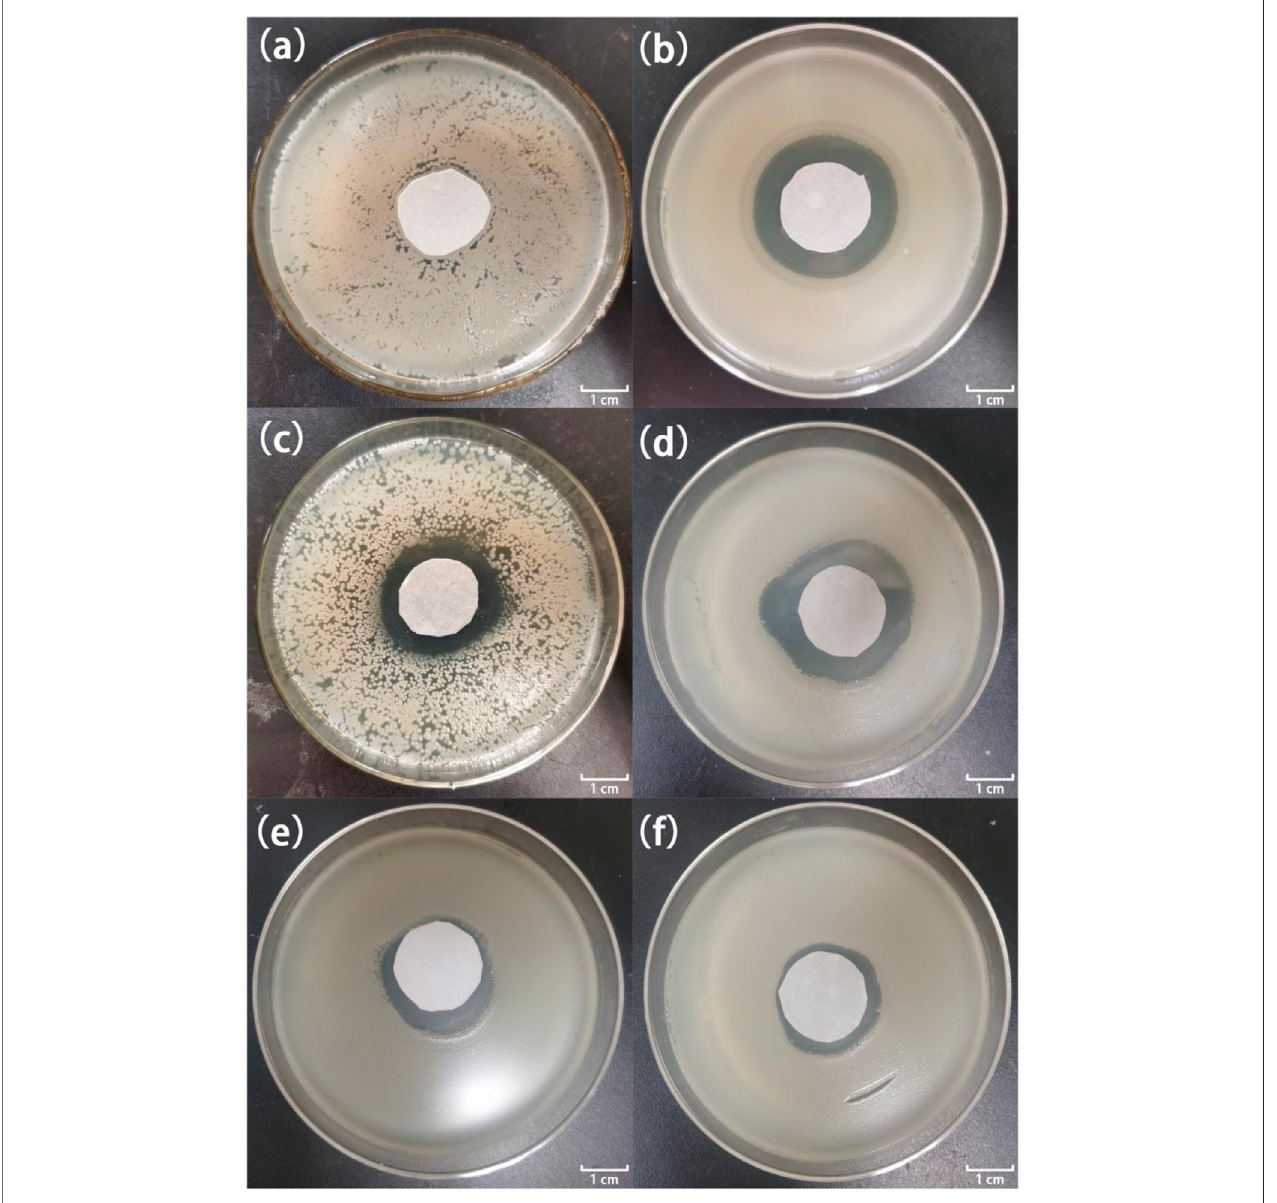
FIGURE 7 | Images of inhibition zones for different samples against E. coli . (A) 0.0 μ g; (B) 20.0 μ g gentamycin; (C) 5.0 μ g LY@ZnO; (D) 20.0 μ g LY@ZnO; (E) 20.0 μ g LY; and (F) 20.0 μ g ZnO.